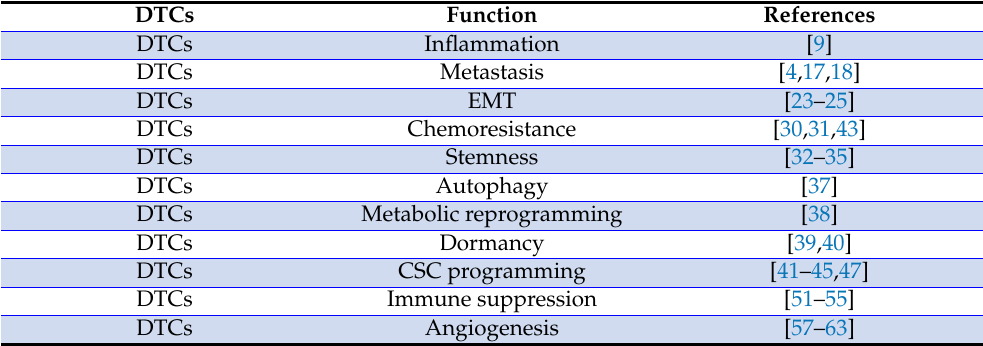
Table 1. Overview of the role and function of disseminated tumor cells in immune cell signaling pathways, drug resistance, and